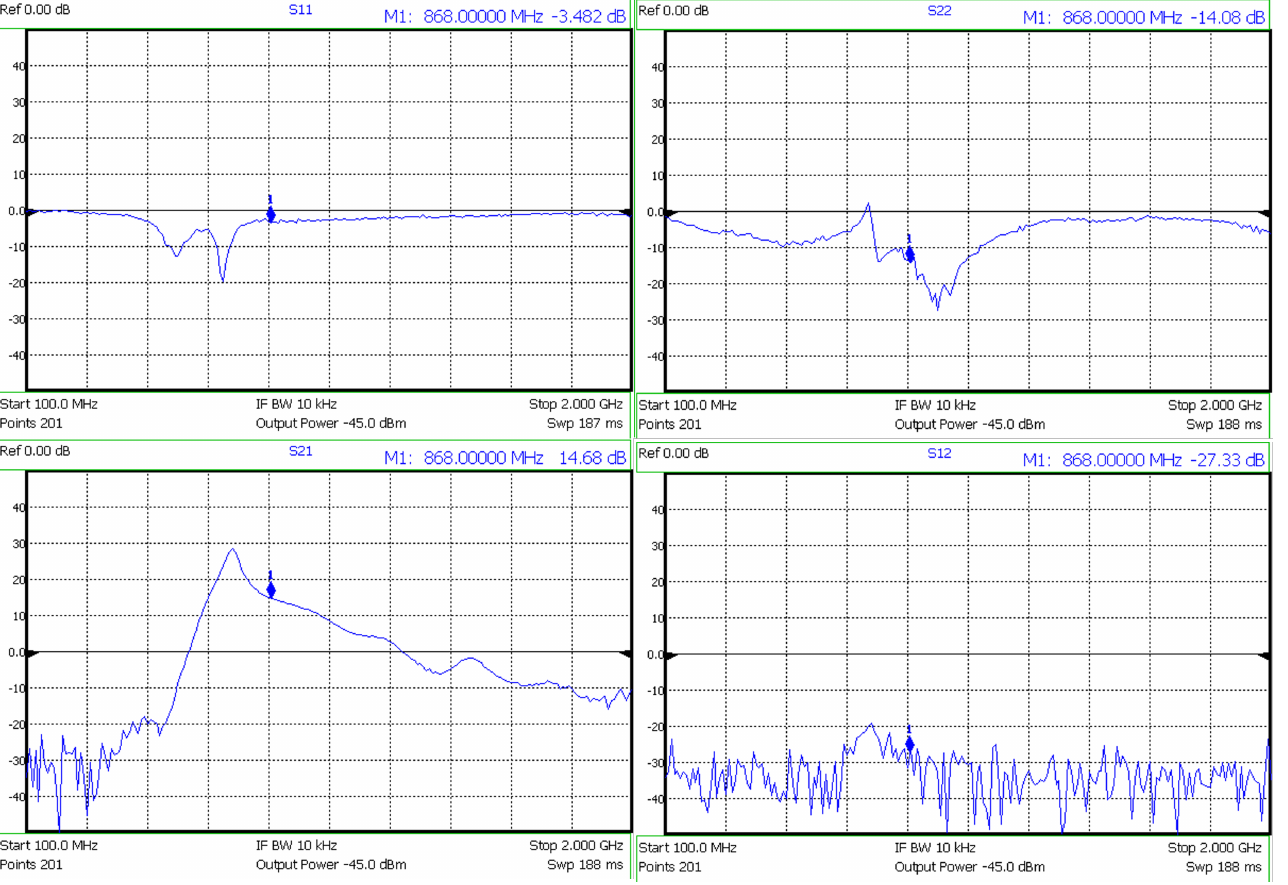
Figure 15. Results of S-parameters of the proposed